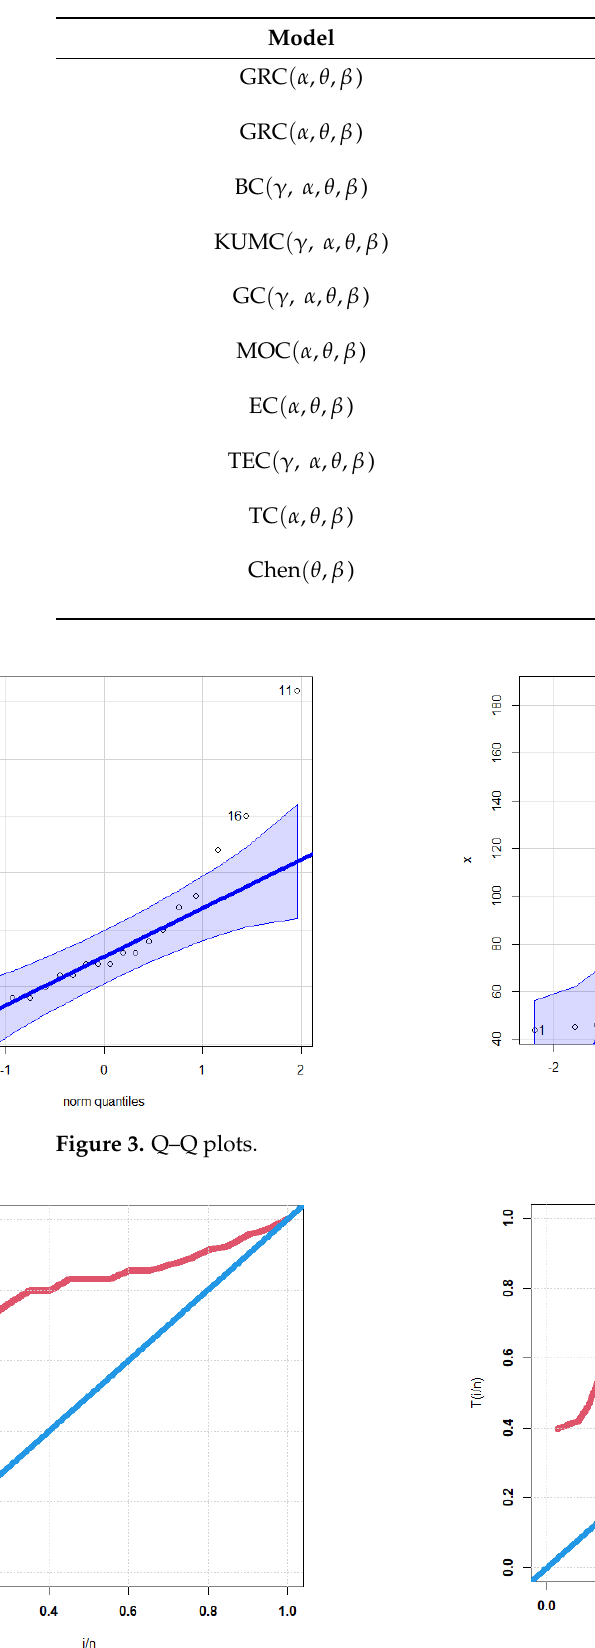
Table 4. The MLEs and SEs for the minimum flow data.